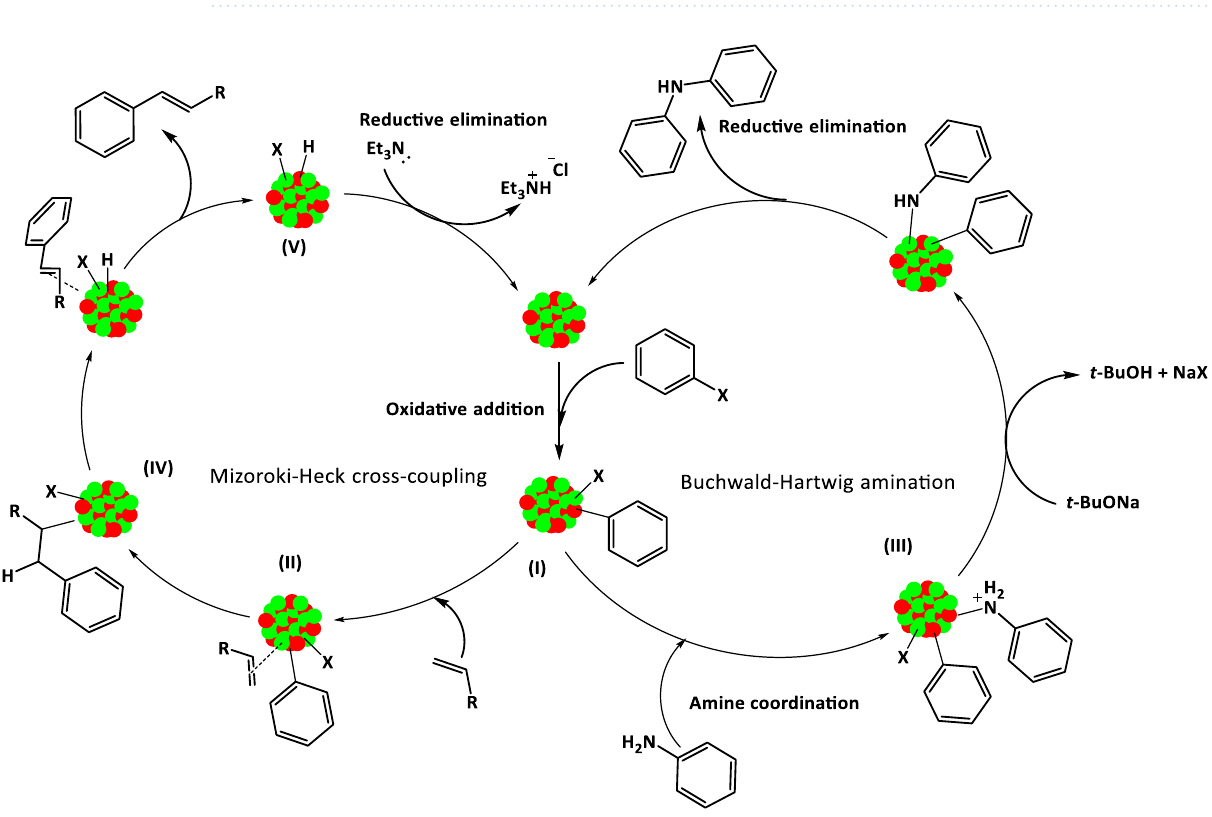
Figure 12. Heck and Buchwald–Hartwig amination reactions of chlorobenzene with n -butyl acrylate and aniline, respectively, catalyzed by γ-Fe 2 O 3 @MBD/Pd, γ-Fe 2 O 3 @MBD/Co, Fe 2 O 3 @MBD/Pd(OAc) 2 , γ-Fe 2 O 3 @ MBD/CoCl 2 , physical mixture of γ-Fe 2 O 3 @MBD/Pd and γ-Fe 2 O 3 @MBD/Co, Pd(OAc) 2 , CoCl 2 .6H 2 O, and Fe 2 O 3 @MBD/Co 3 O 4 γ-Fe 2 O 3 @MBD/Co-Pd; Reaction conditions: ( a ) chlorobenzene (1 mmol), n- butyl acrylate (1.3 mmol), catalyst (0.05 mol% based on the Pd content or 0.21 mol% based on the Co content), Et 3 N (2 mmol), water (1 mL), 50 °C, ( b ) chlorobenzene (1 mmol), aniline (1.2 mmol), water (1 mL), catalyst (0.07 mol% based on the Pd content or 0.29 mol% based on the Co content), t -BuONa (2 mmol), water (1 mL), 80